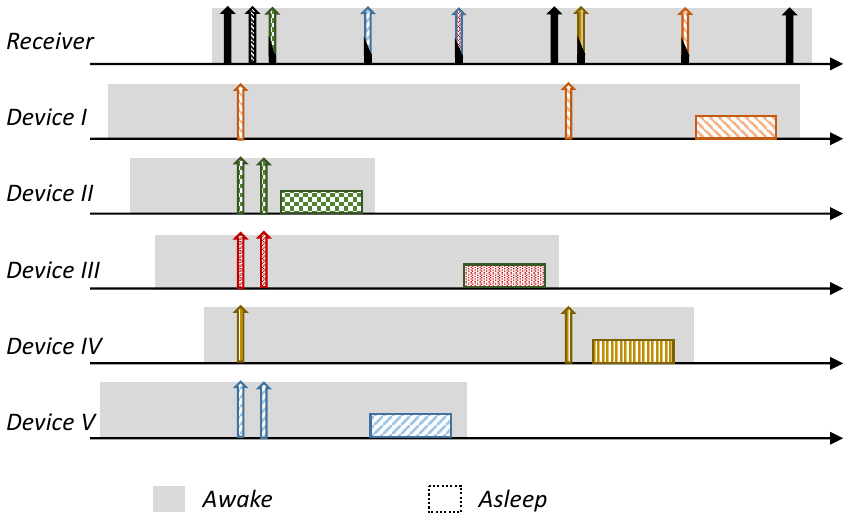
Figure 6. MAR-RiMAC collision resolution procedure illustration for K = 4. After the sink’s “Ready to Receive” (RtR) beacon, five devices (more than K = 4) attempt transmission. The sink sends a “Ready to Receive Retransmissions” (“RtRR”) to resolve the conflict, which is replied to by three devices (less than K = 4). The other two devices transmitted after the sink finished polling the three devices and sent a new